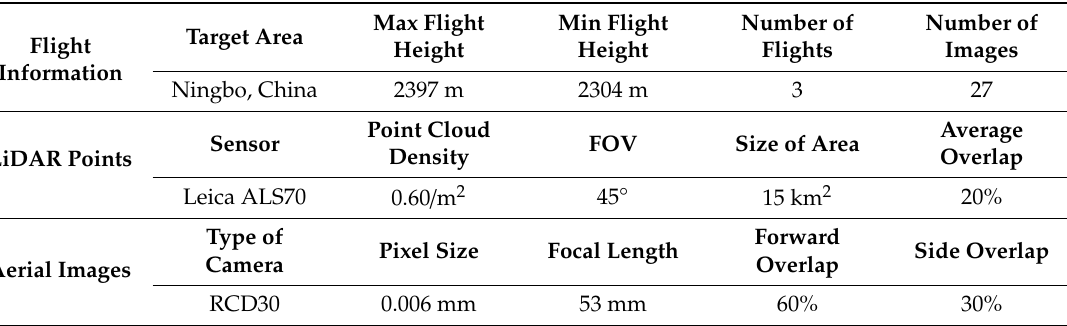
Table 2. Technical parameters of Dataset